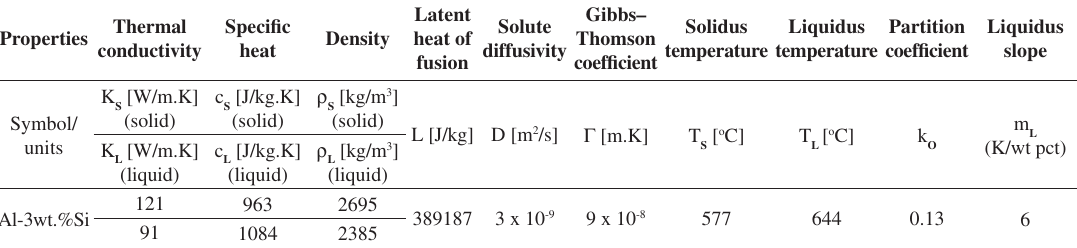
Table 2. Casting material used for experimentation and the corresponding thermophysical properties 4